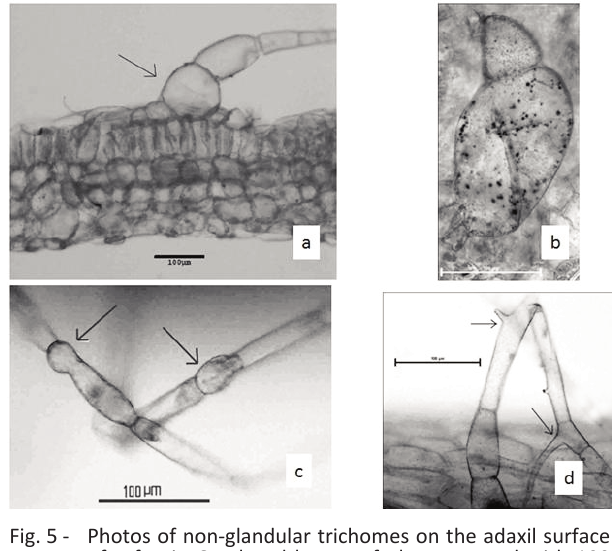
Fig. 5 - Photos of non-glandular trichomes on the adaxil surface of safranin O.colored leaves of plants treated with 100 mM salt concentration; A) branched trichomes (Draga) (arrows), B) two non-glandular trichomes with swollen stem cells (Draga) (arrows), C-D) a non- glandular tri- chome with very large base cell (arrow) compared to the adjacent cells: C) from Draga, D) from Spunta. (arrows). Bars=100